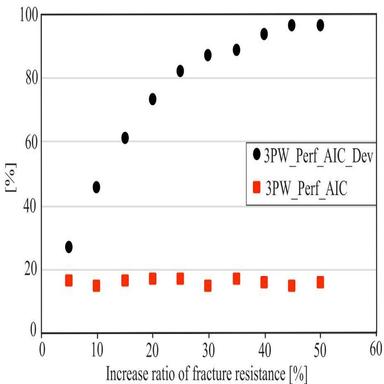
Fitting performance of 3P-Weibull distribution function as a function of increase ratio of fracture resistance from KI0.